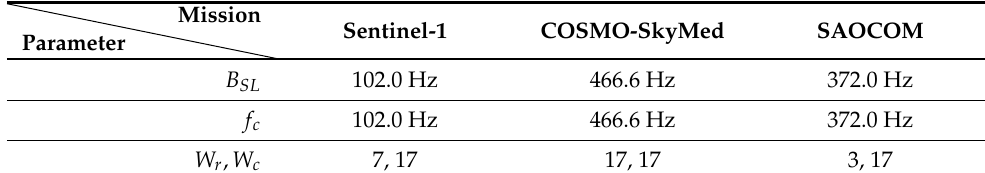
Table 4. Parametersused for the sub-look analysis of Sentinel-1, COSMO-SkyMed, and SAOCOM missions.